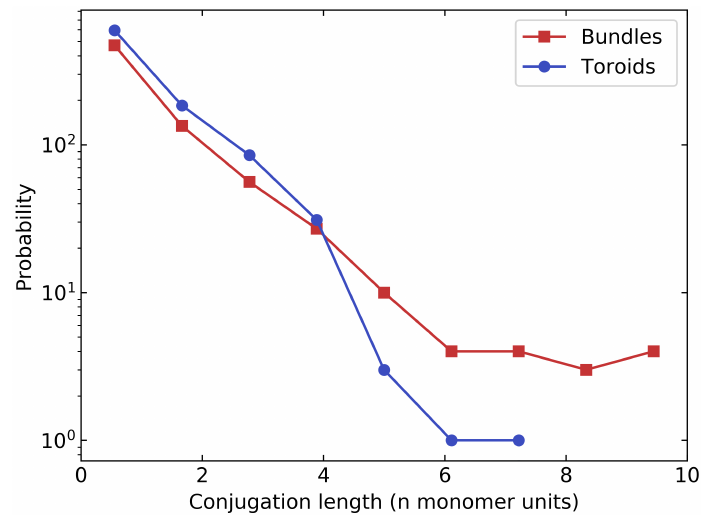
Figure 11. Distribution of conjugation lengths in toroids and bundles for P3HT in THF